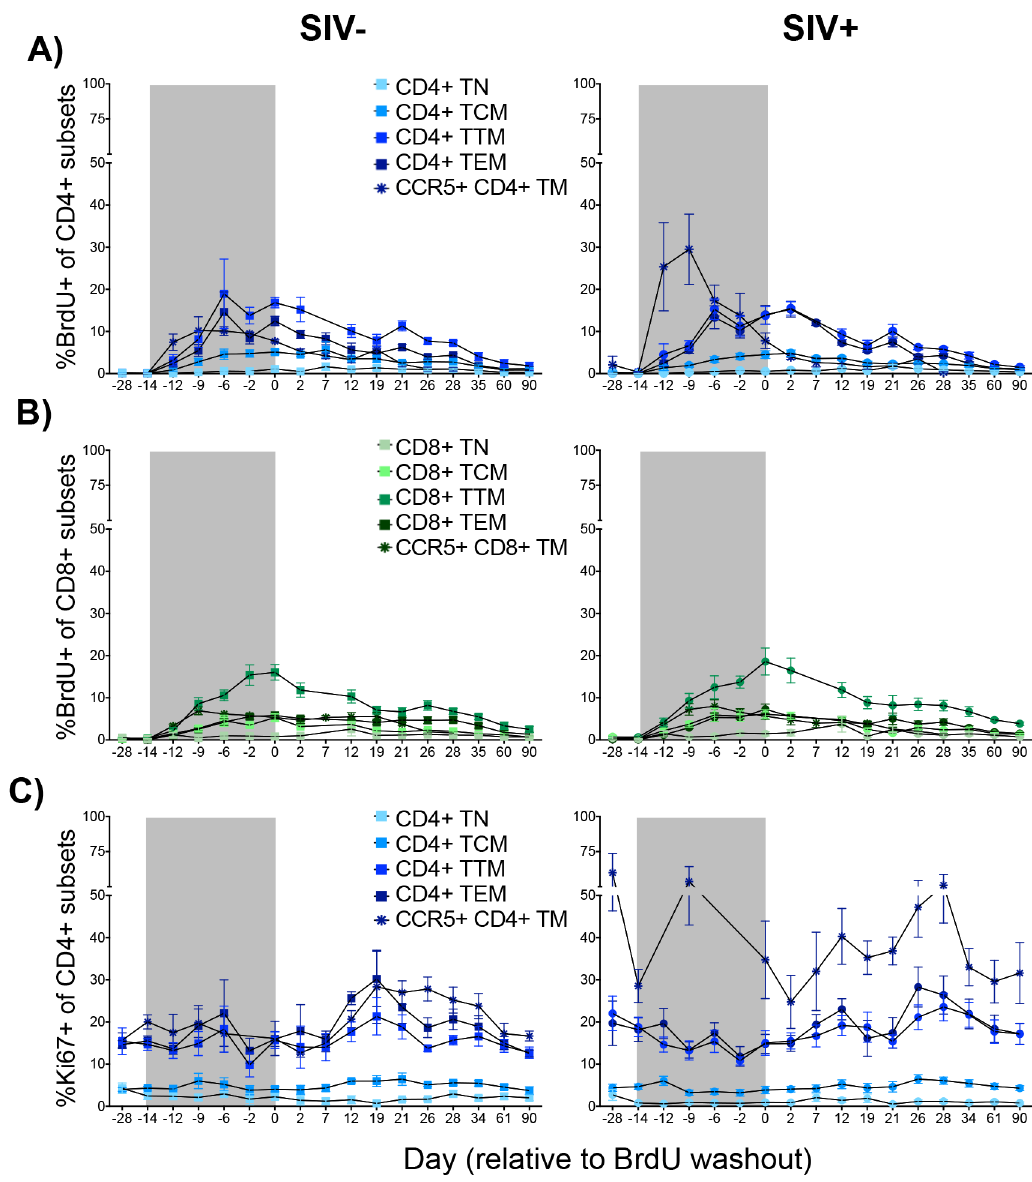
Fig 2. BrdU and Ki67 Expression By CD4+ and CD8+ T-cell Subsets. A-B. ( ± SEM) percent BrdU expression was assessed longitudinally by flow cytometry among CD4+ (A) and CD8+ (B) T N , T CM , T TM , T EM , and CCR5+ TM in uninfected (left) and SIV-infected (right) animals. C. Mean ( ± SEM) longitudinal Ki67 expression of CD4+ T N , T CM , T TM , T EM , and CCR5+ TM in uninfected (left) and SIV-infected (right) animals. p = NS between infected and uninfected controls at all timepoints for all populations (Mann-Whitney U). Shaded area represents BrdU administration period. Data points are shown only for animals above which 100 events were collected for the parent